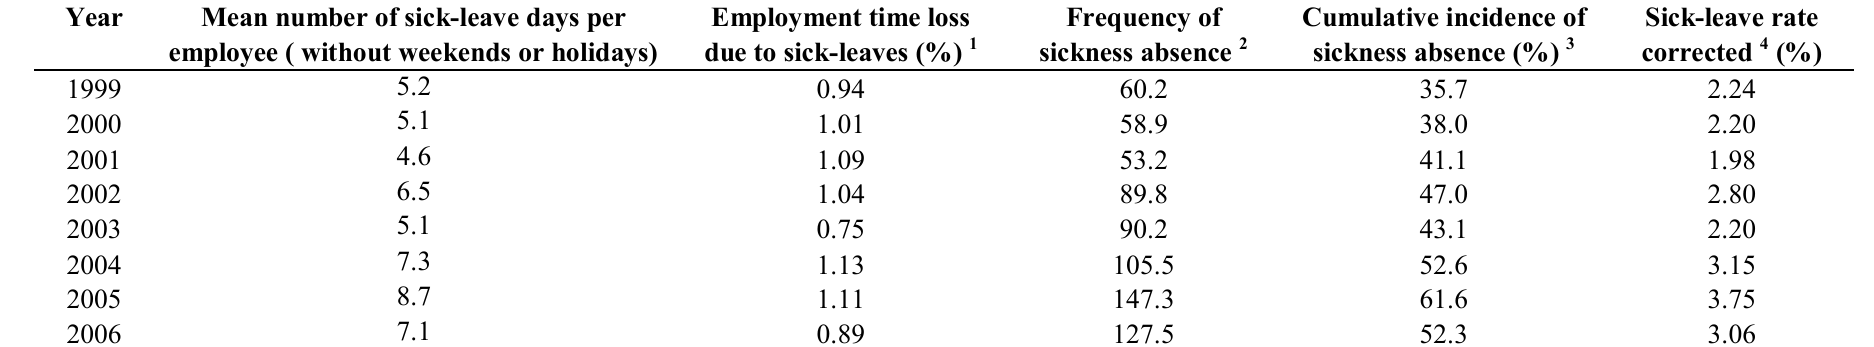
Table 3. Sickness absence in a shipyard industry in Greece in 1999–2006, presented by year using different measures. Year Mean number of sick-leave days per employee ( without weekends or